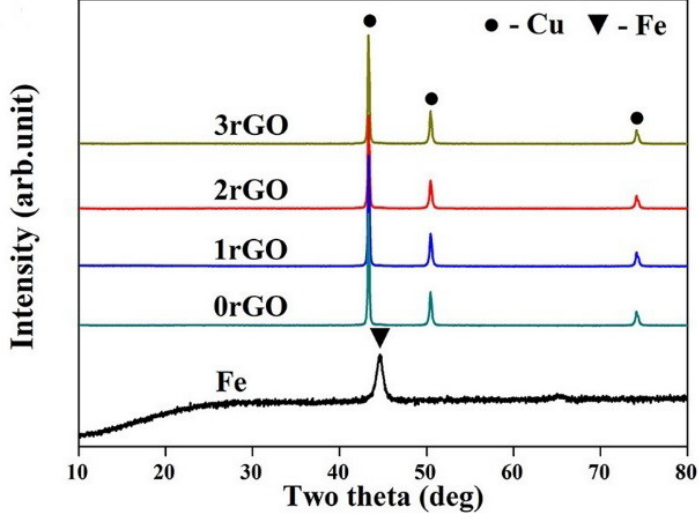
Figure 1. XRD patterns of the mixture powders and original Fe.